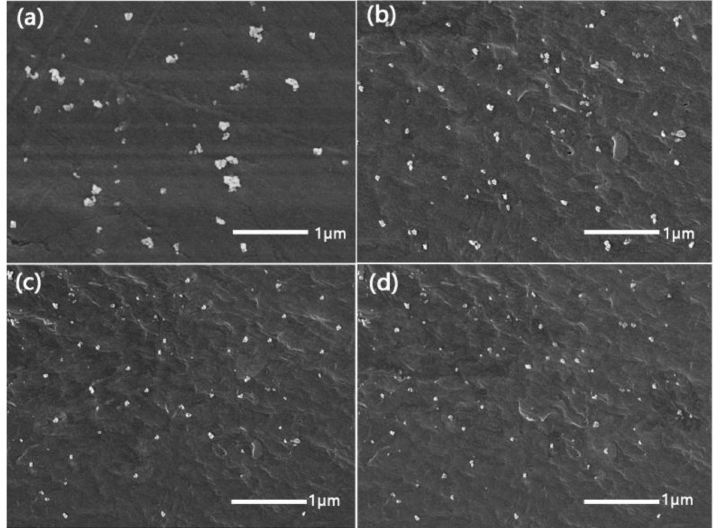
Figure 4. FESEM images of composites ( a ) PET/SiO 2 ; ( b ) PET/PET-3; ( c ) PET/PET-4 and ( d ) PET/PET-5.